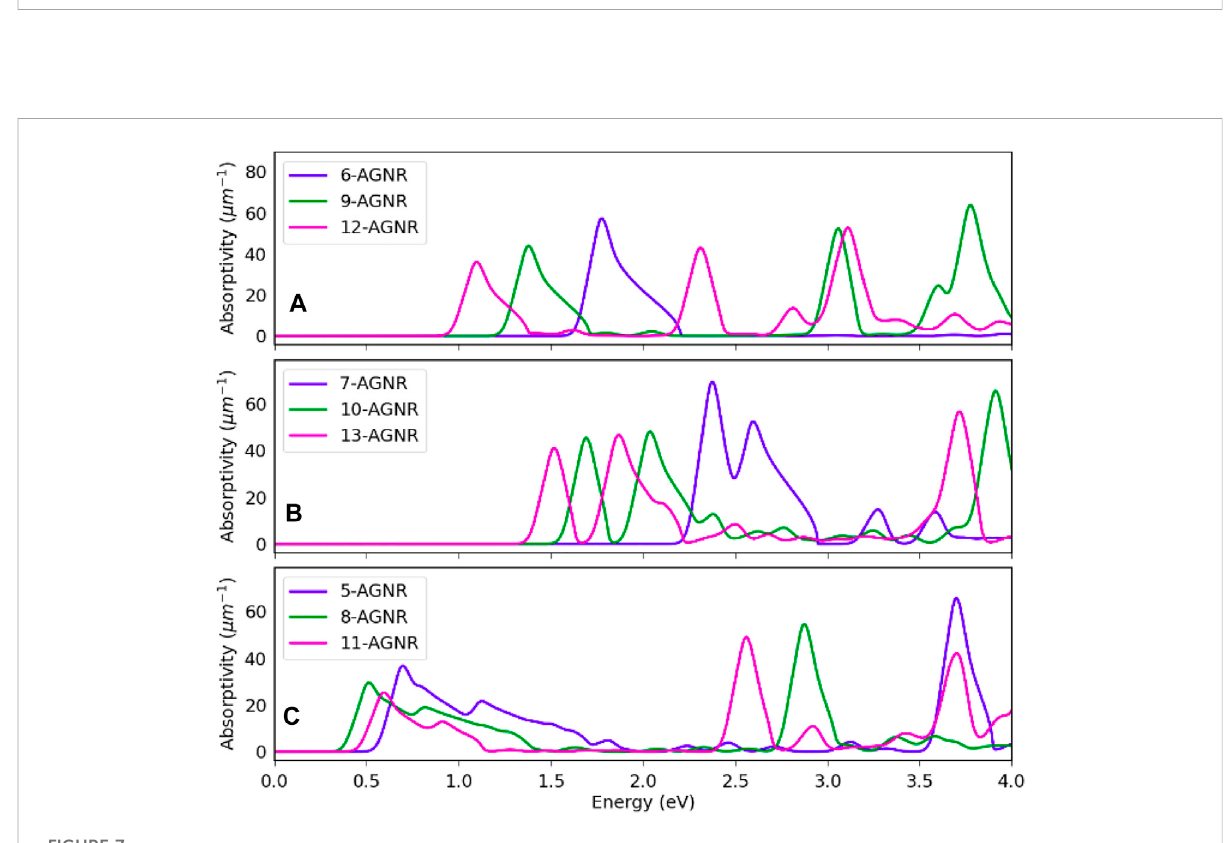
FIGURE 7 Absorptivity of single layer armchair graphene nanoribbons. (A) Absorptivity of the 3 n family nanoribbons. (B) Absorptivity of the 3 n + 1 family nanoribbons. (C) Absorptivity of the 3 n + 2 family nanoribbons.